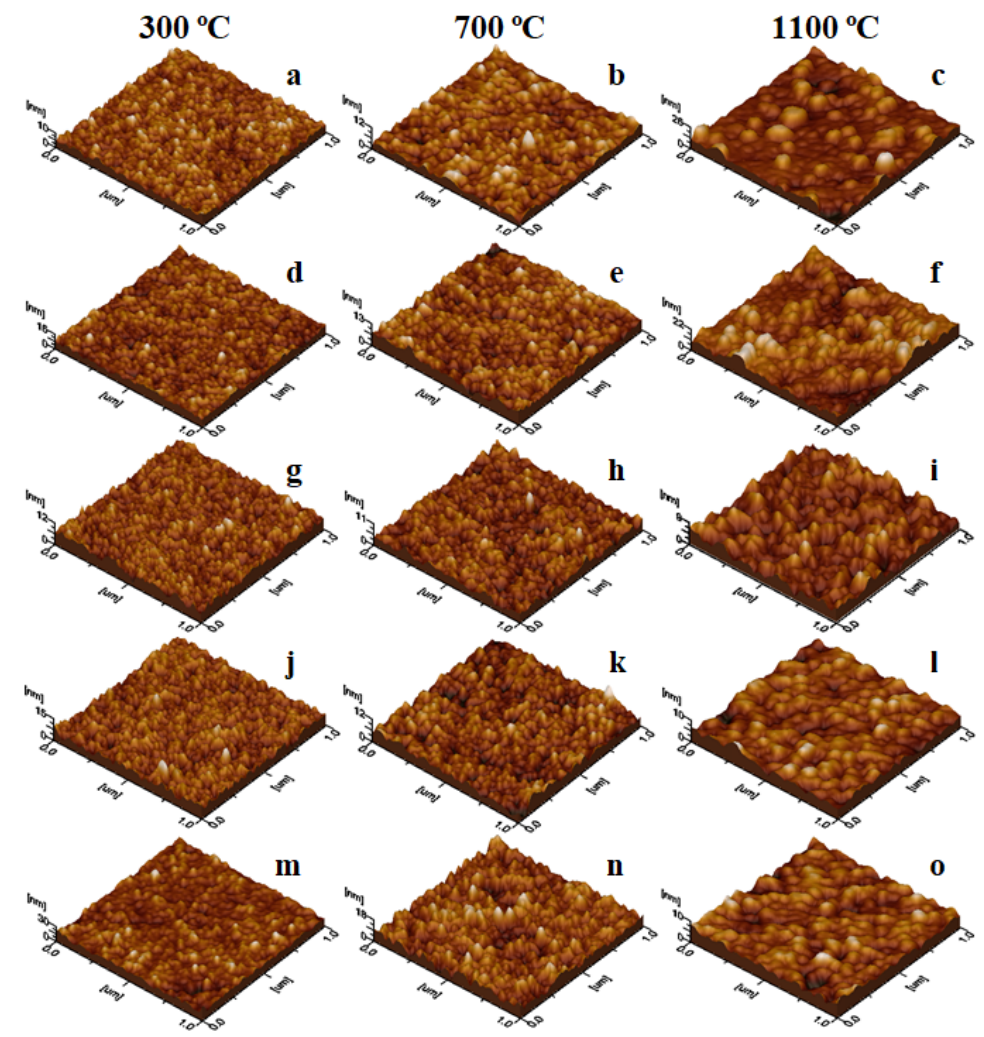
Figure 3. 3D AFM images of (N i0 . 6 Mn 0 . 4 Fe 2 O 4 ) α (SiO 2 ) 100 −α NCs α = 100% ( a – c ); α = 25% ( d – f ); α = 50% ( g – i ); α = 75% ( j – l ) and α = 100% ( m – o ) calcined at 300, 700 and 1100 °C.